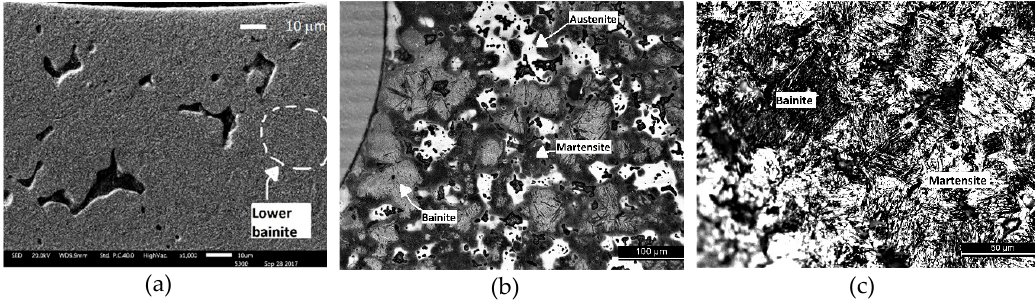
Figure 4. Microstructure of the investigated material variants. ( a ) case-hardened A85Mo05, ( b ) sinter- hardened DHP, ( c ) sinter-hardened DDH.